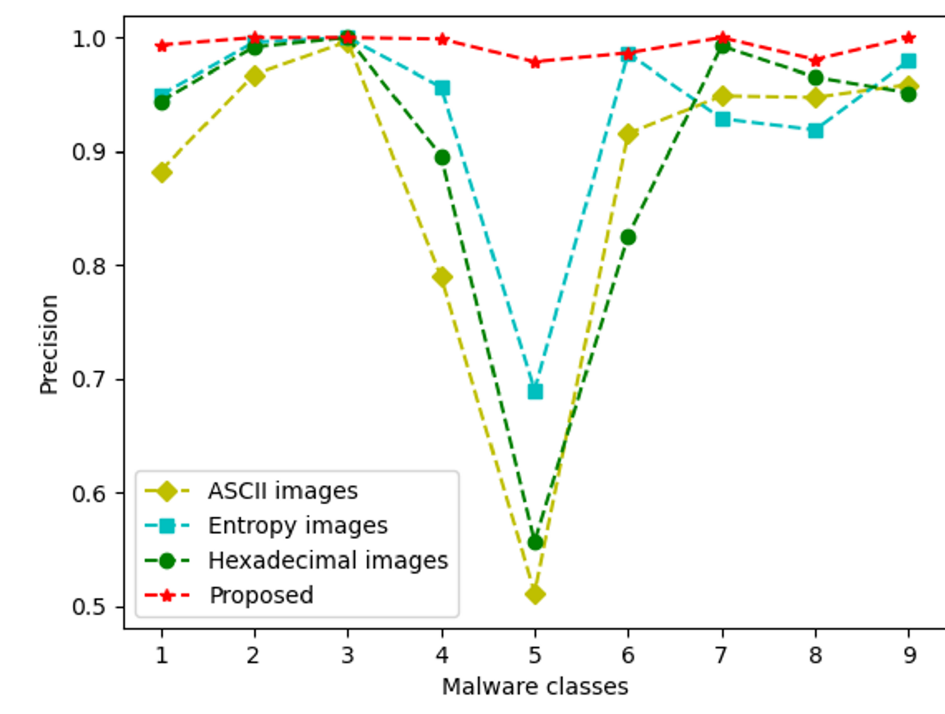
Figure 8. Precision of different grayscale images and multi-channel images.